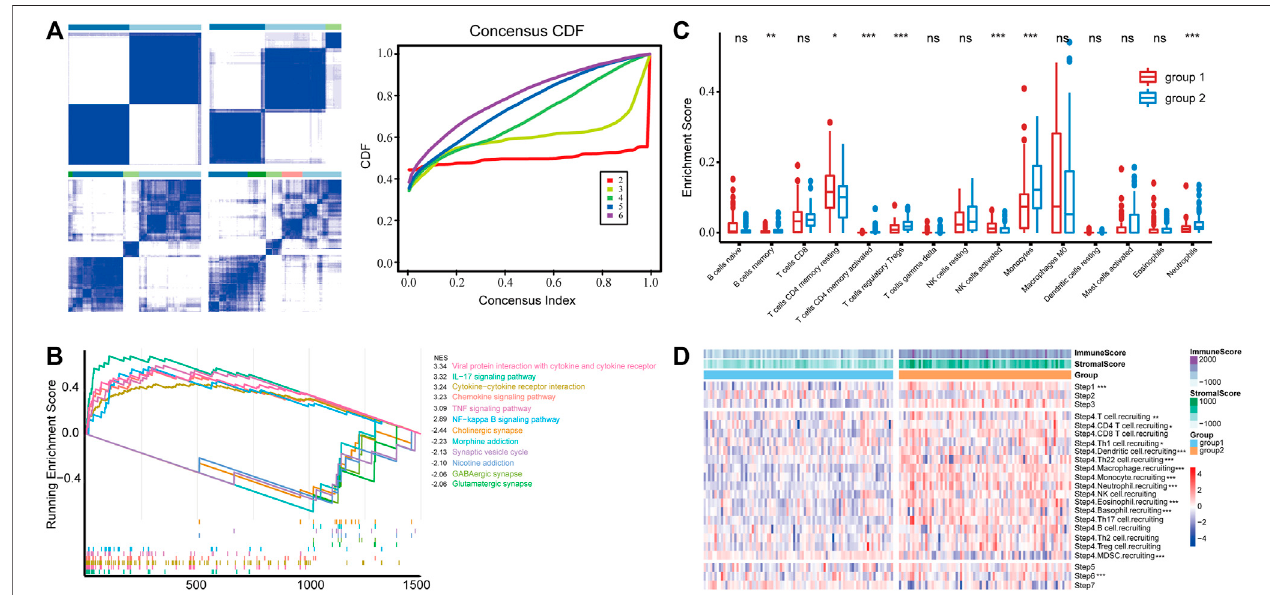
FIGURE1|(A) ConsensusclusteringoftheGBMsamplesbasedontheexpressionofIRGs,andempiricalcumulativedistribution function(CDF)correspondingto theentriesofconsensusmatrices. (B) GSEAanalysisoftoppathwaysenrichedingroup1andgroup2,respectively. (C) Immunein fi ltrationisestimatedbyCIBERSORT. Cell with an estimated fraction of 0 in more than half of the samples was fi ltered. (D) The anti-tumor immune response was divided into seven stepwise events, and the activityofeachwasassessedusingtheTIPsystem.***inStep6suggeststhatgroup1hasasigni fi cantlyhigherTIPscorethangroup2,andtherestindicatehigher in group